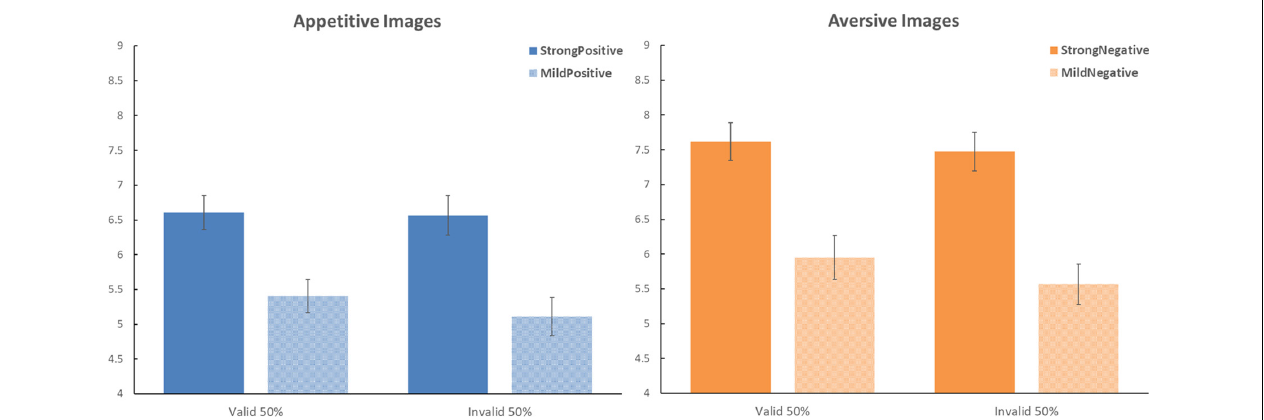
FIGURE 1 | Effects of predictive cues on the evaluation of food images in Experiment 1. The left panel shows the data for the appetitive images. The right panel shows the data for the aversive images. Dark blue and dark orange bars present the data for the strong images; the light-shaded bars present the data for the mild images. On the horizontal axes, the bars are separated as a function of the validity of the predictive cues. Error bars represent the standard error of the mean. In this experiment, the framing by the predictive cues did not correlate with the outcome; there was an equal probability for the cue to be valid (i.e., matching valence with the outcome) or invalid (i.e., mismatching valence with the